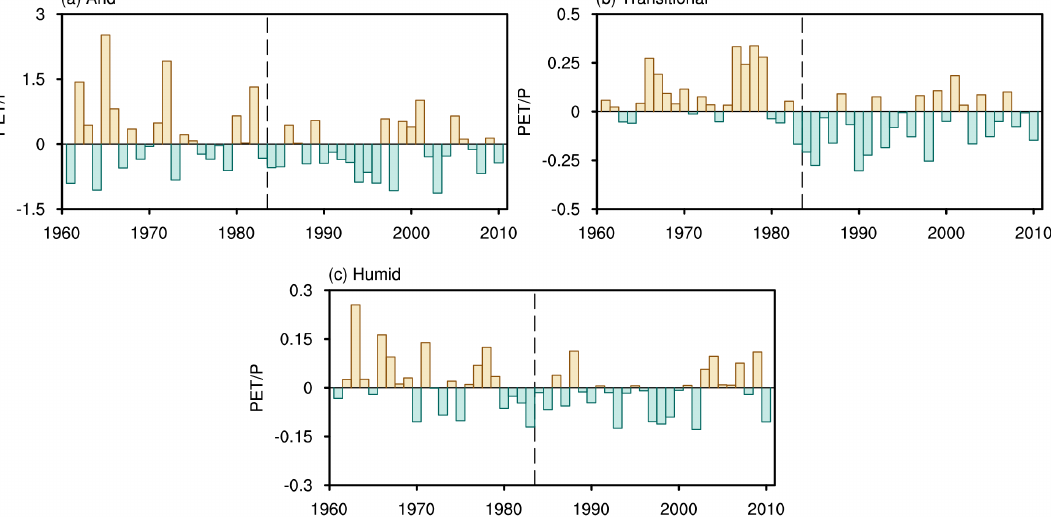
Figure 4. Interannual variations in the annual mean PET /P over the (a) arid, (b) transitional, and (c) humid regions located to the east of 100 ◦ E. Yellow and blue bars indicate the positive and negative anomalies for PET /P ,